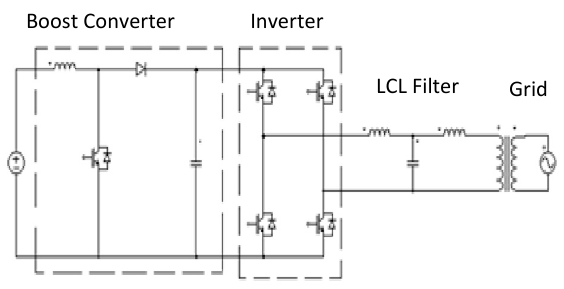
Figure 2. Photovoltaic system in grid mode.